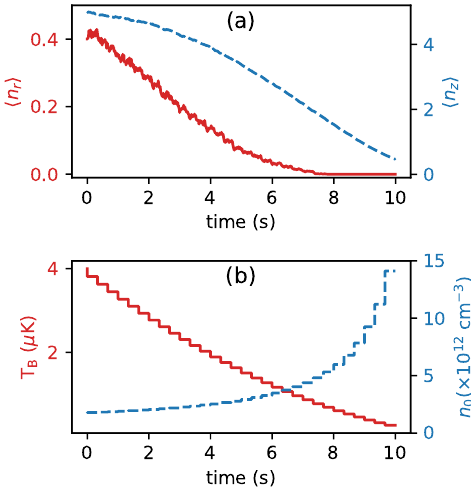
Figure 3. Trapped atom interacting with a bath that is continuously undergoing evaporative cooling. ( a ) Radial and axial mean vibrational occupation numbers are shown by red solid and blue dashed lines, respectively. Here, the final occupation numbers are (cid:104) n (cid:48) r (cid:105) = 0.00 and (cid:104) n (cid:48) z (cid:105) = 0.46, meaning that the atom always ends up in the ground state of the radial direction. ( b ) The temperature and the atomic density of the bath atoms are shown by red solid and blue dashed lines, respectively. Here, ω / ( 2 π ) = 100 kHz, a = 160 a 0 , η y = 0.98, and η z = 0.105 for all graphs.